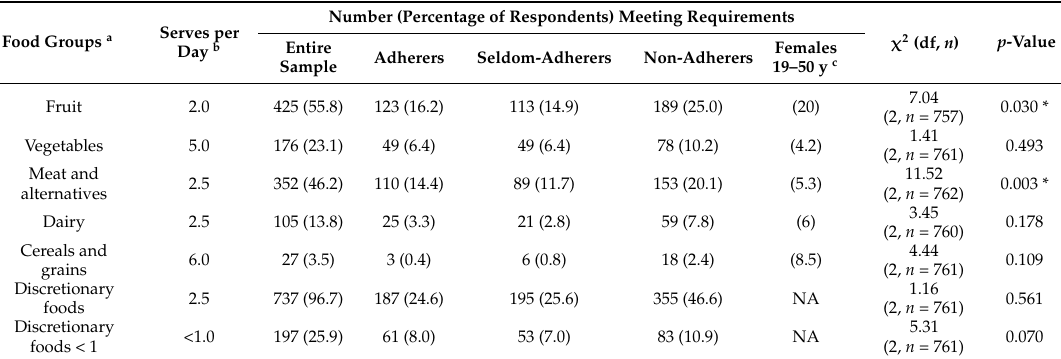
Percentage comparison of whole cohort, as well as adherers, seldom-adherers and non-adherers, for meeting AGHE guidelines, as well discretionary food